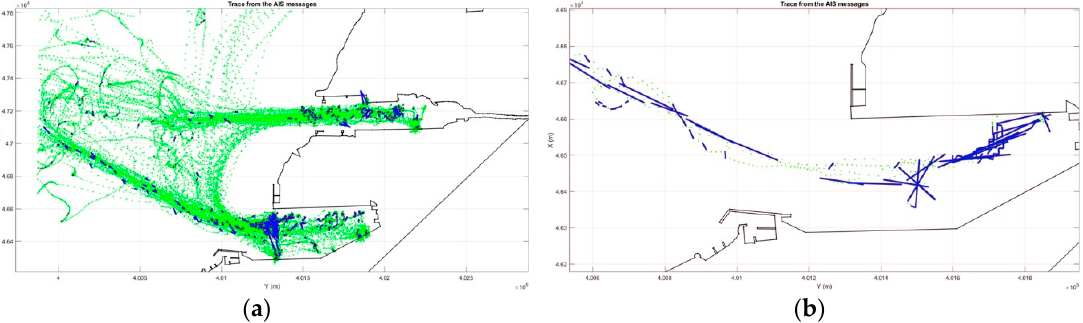
Figure 7. Anomalous parts of the tug’s Zeus track ( a ) and container ship Murat K track ( b ) as observed in AIS messages from September 1-24 2019, Port of Koper, coordinate system D96 (UTM) .